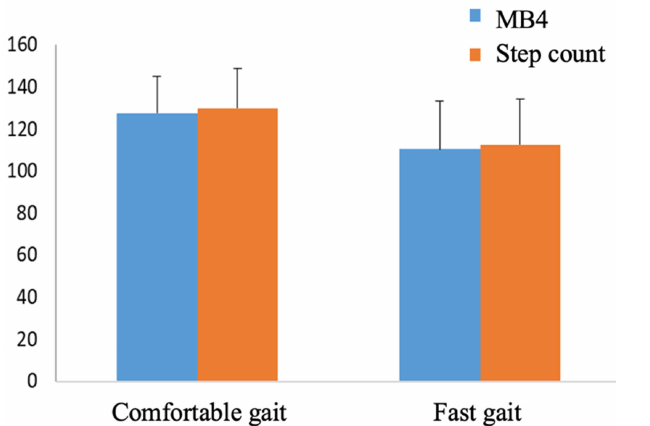
Figure 4. Number of steps obtained in comfortable and fast gait by MB4 and the target count by video. Bland-Altman plots in the process of calculating the concordance between MB4 and SW in the different protocols are showed in Figure 5.